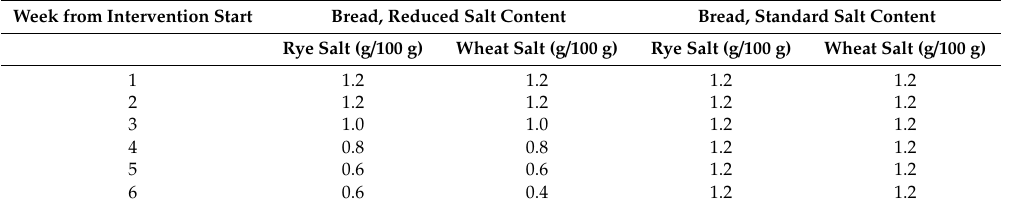
Table 1. Salt content in bread—Six weeks of gradual reduction, hereafter same level as week six. Week from Intervention Start Bread, Reduced Salt